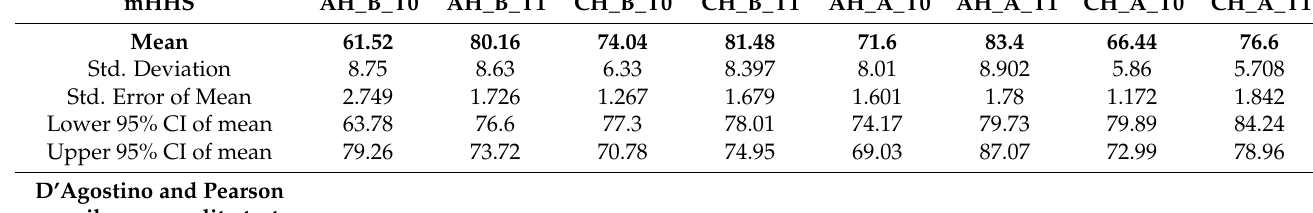
Table 1. Normality test results of the mHHS, for all studied sample groups (hip (AH/CH), treatment (B/A), time (T0/T1)).